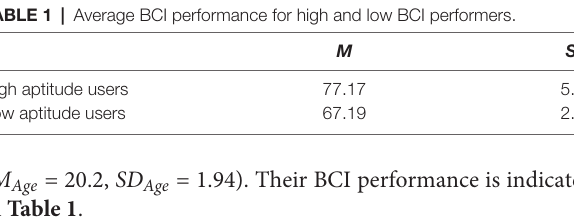
TABLE 1 | Average BCI performance for high and low BCI performers.